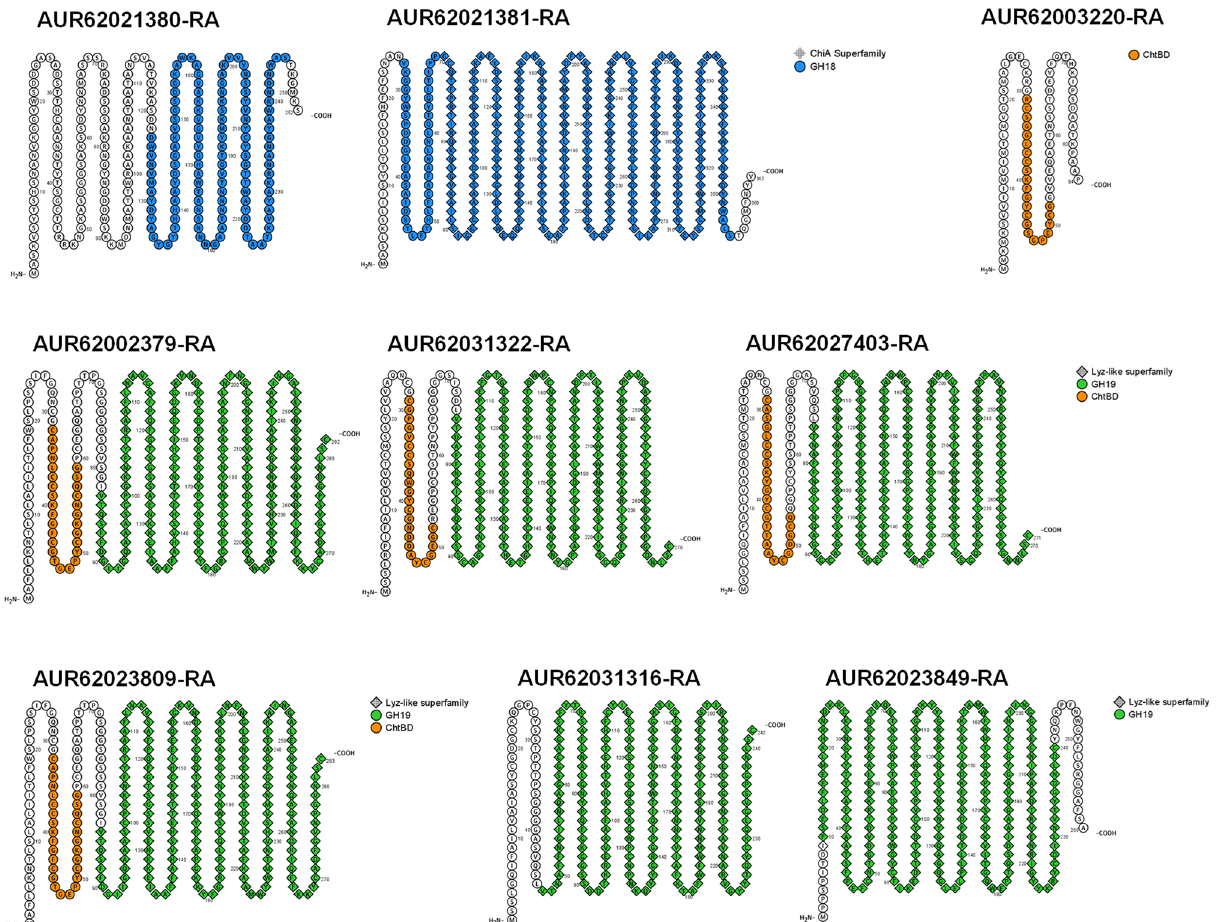
Figure 5. Conserved domain (CD) prediction for the 9 chitinase-related proteins identified in quinoa seeds under rainfed conditions. Representation of predicted conserved domains for the 9 chitinase-related proteins identified in quinoa seeds harvested from rainfed conditions, using Protter (http:// wlab. ethz. ch/ prott er/